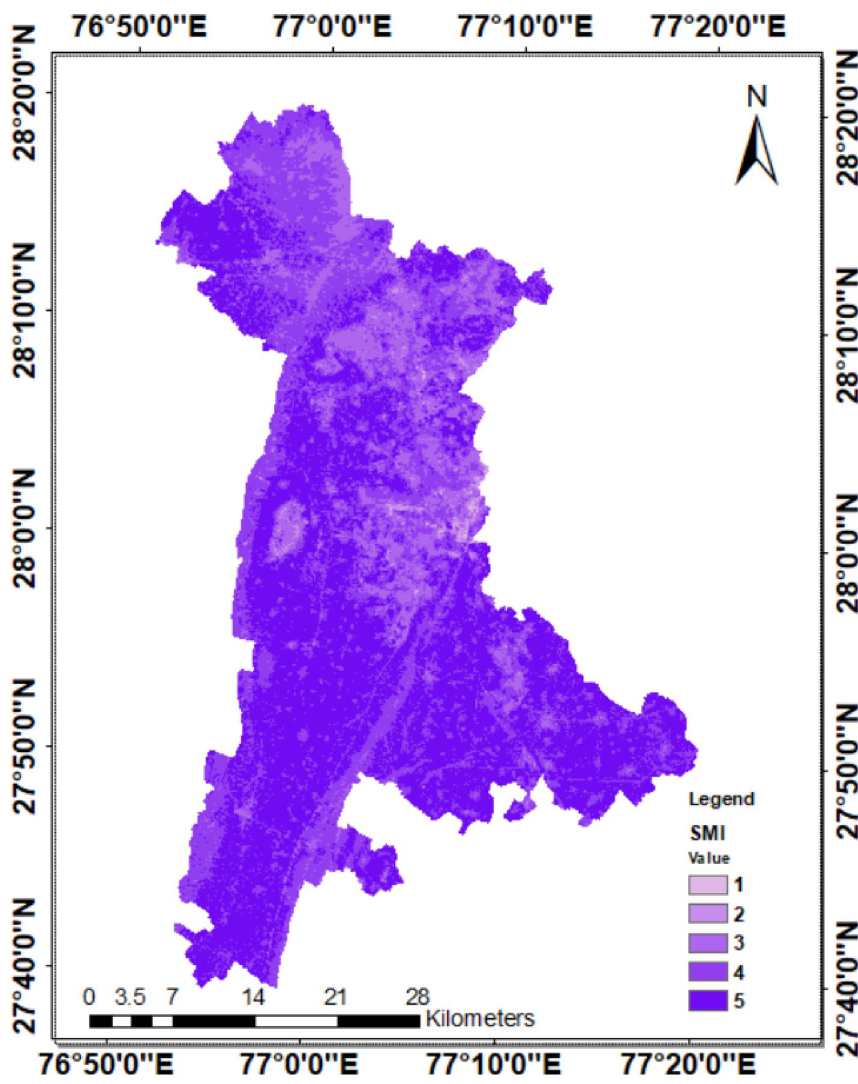
Fig. 13 Soil moisture index (SMI) map of study